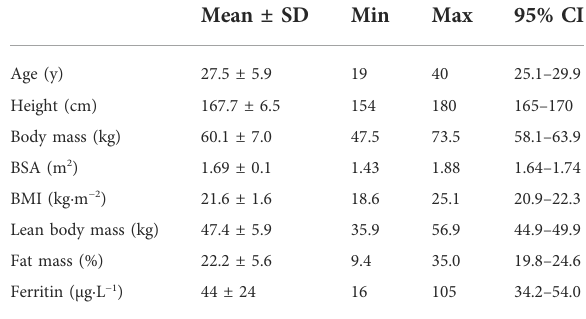
TABLE 1 Subject characteristics ( n =